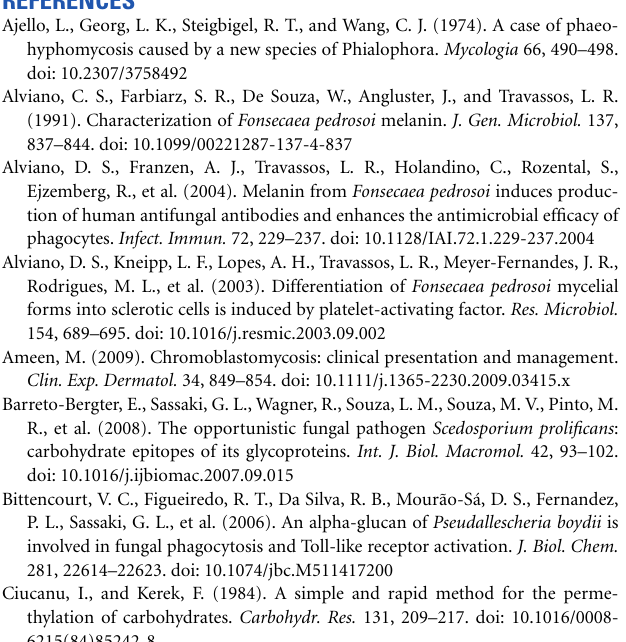
Figure S1 | Immunoassay with antigens existing on the serum of patients with chromoblastomycosis (black bars), patients without chromoblastomycosis (white bars). Antigens were assessed to determine their capacity of reaction in the formation of immune complexes with wall polysaccharides of the fungus F. monophora . Antigen 1 (Ag1), belonging to the cell wall of strain MMHC82 drawn from MM, antigen 2 (Ag2), cell wall antigen of strain MMHC82 from CD medium, antigen 3 (Ag3), cell wall antigen from strain FE5p4 from MM and antigen 4 (Ag4), cell wall antigen from strain FE5p4 from CD medium. Results correspond to the medium ± E.P.M of 6–12 samples. ∗∗∗ p < 0 . 001 in relation to the control group, serum of non-chromoblastomycosis patient (ANOVA of a pathway followed by t- test with a Bonferroni